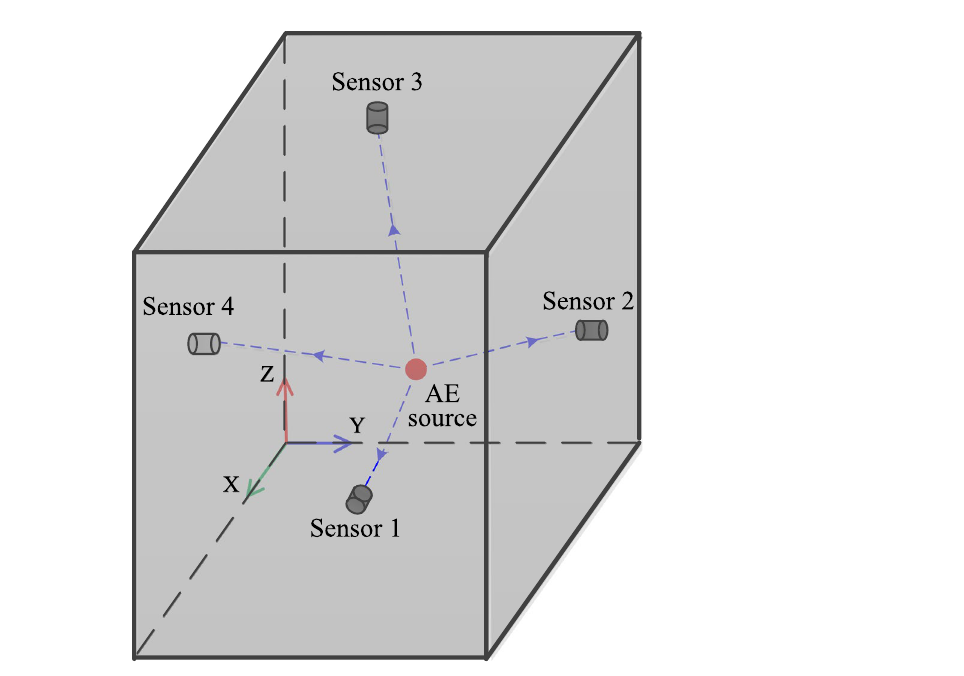
Figure 3. The schematic of the 3D TDOA location of an AE